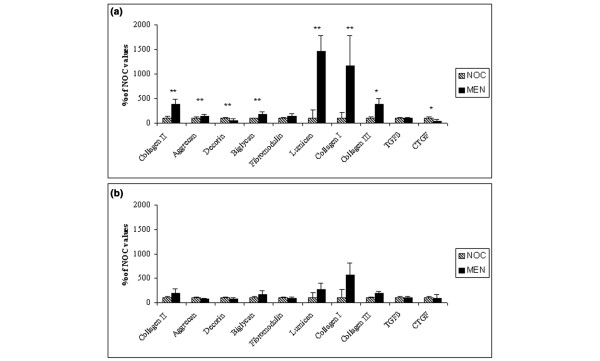
Changes in mRNA levels. Changes in (a) lateral tibial plateau (LTP) and (b) medial tibial plateau (MTP) cartilage mRNA levels of aggrecan, type I, II, and III collagen, decorin, biglycan, fibromodulin, lumican, transforming growth factor (TGF)-β and connective tissue growth factor (CTGF) following lateral meniscectomy (MEN) relative to nonoperated control (NOC) values. Values are expressed as mean ± standard deviation. There were three samples for the NOC MTP, six for the NOC LTP, five for the MEN MTP and six for the MEN LTP groups. *P < 0.05, **P < 0.01.